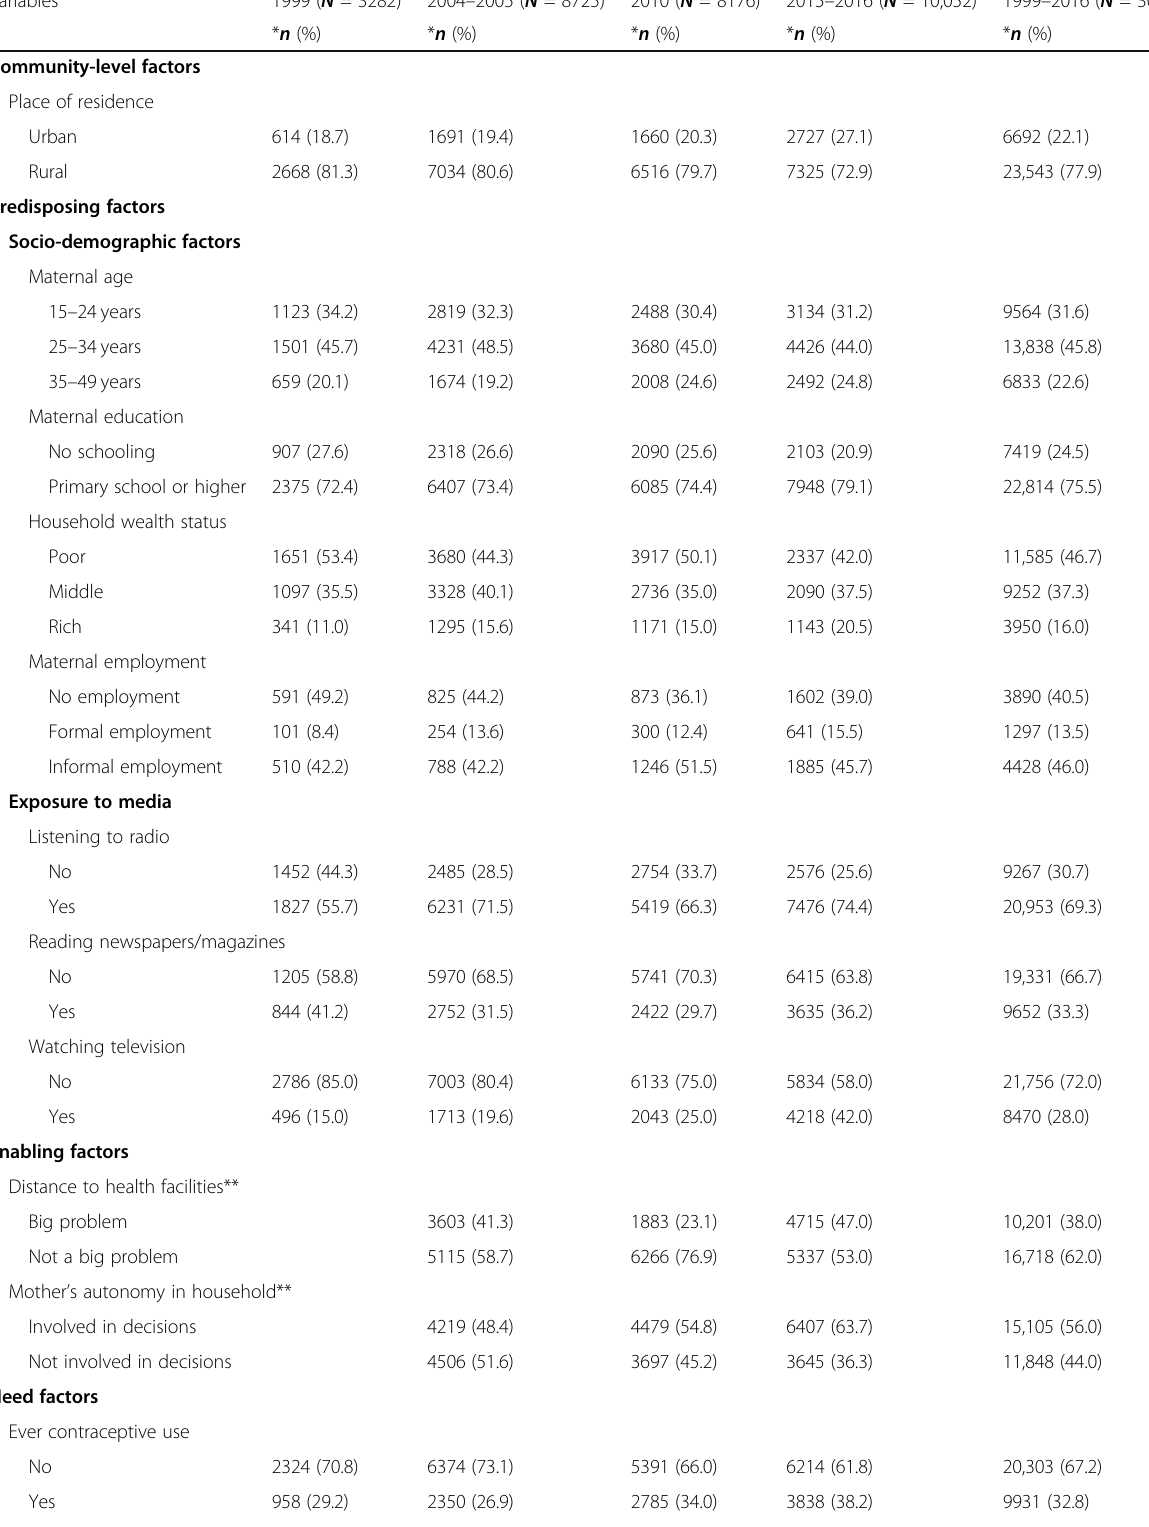
Table 1 Characteristics of the study